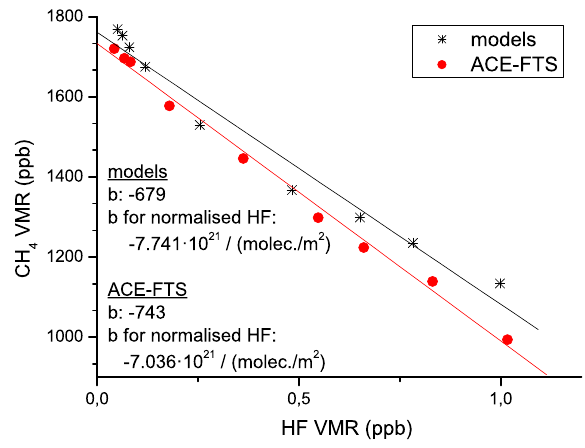
Fig. A1. HF volume mixing ratio versus CH 4 volume mixing ratio between the levels 10 and 100 hPa. The solid lines represent the regression line for models (black line) and ACE-FTS (red line). The b-values are also shown for the normalised HF